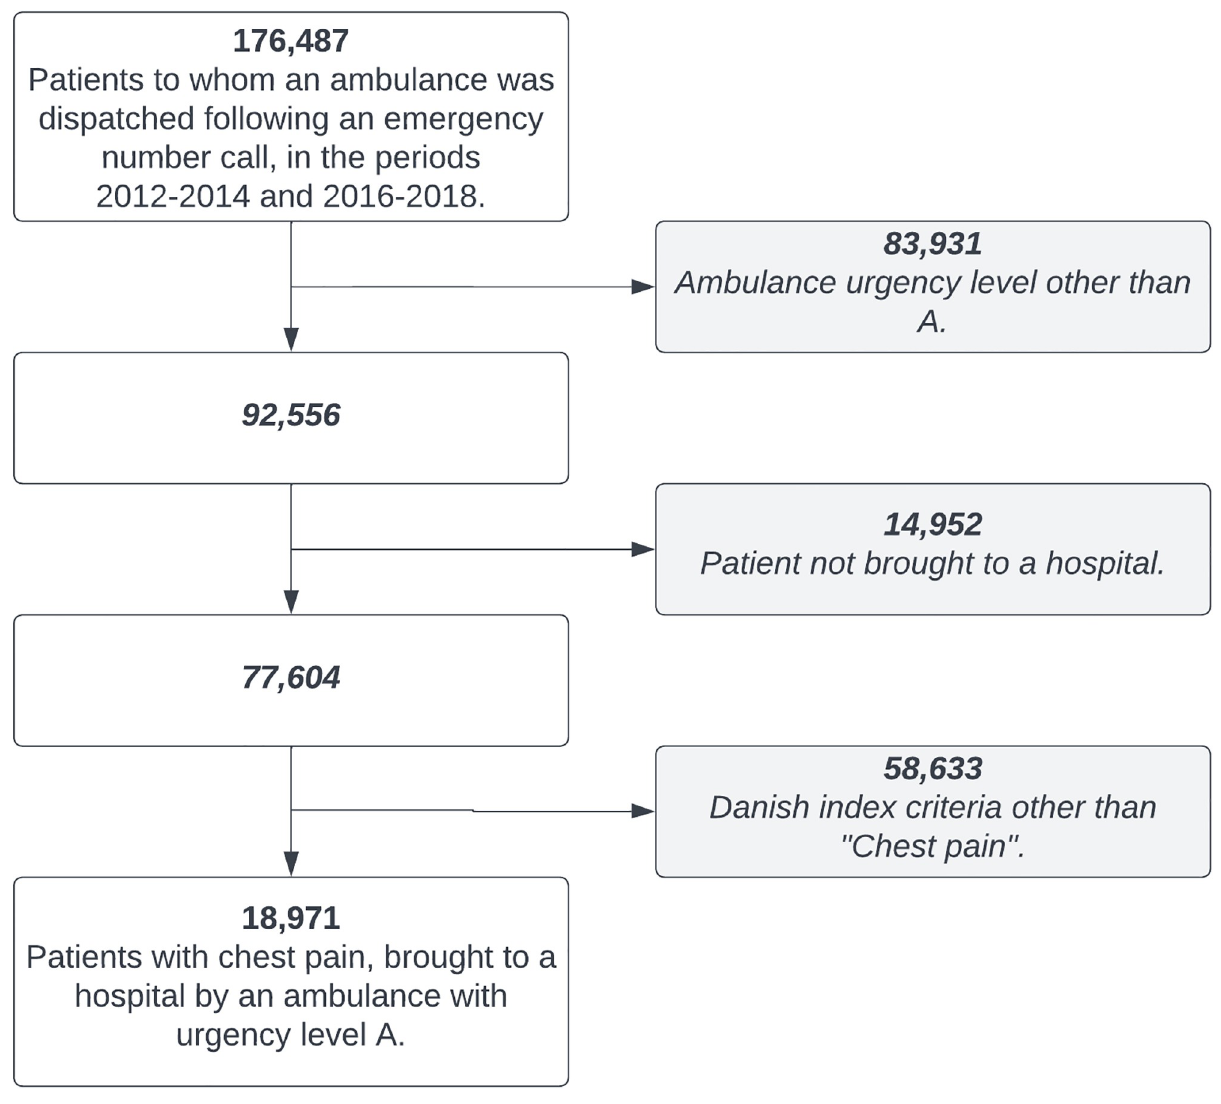
Fig 1. Flowchart of the included study population. However, among the patients with chest pain, the proportion subsequently diagnosed with AMI remained stable, with a tendency towards 0.12 fewer patients per year, although not sta- tistically significant (Table 2) (linear regression: p = 0.15, 95% CI: -0.34 to 0.07). Mortality For all included patients, the overall 48-hour mortality was 0.6% (95% CI 0.5% to 0.7%) and 30-day mortality was 2.4% (95% CI 2.2% to 2.6%). The 48-hour mortality ranged from 0.5 to 0.8%; and 30-day mortality from 2.1 to 2.9%. For patients subsequently diagnosed with AMI, the overall 48-hour mortality was 1.1% (95%CI 0.8% to 1.8%), and 30-day mortality was 4.4% (95% CI 3.6% to 5.4%). The 48-hour mortality ranged from 0.8% to 1.4%, whereas the 30-day mortality ranged from 4.2% to 5.0%.